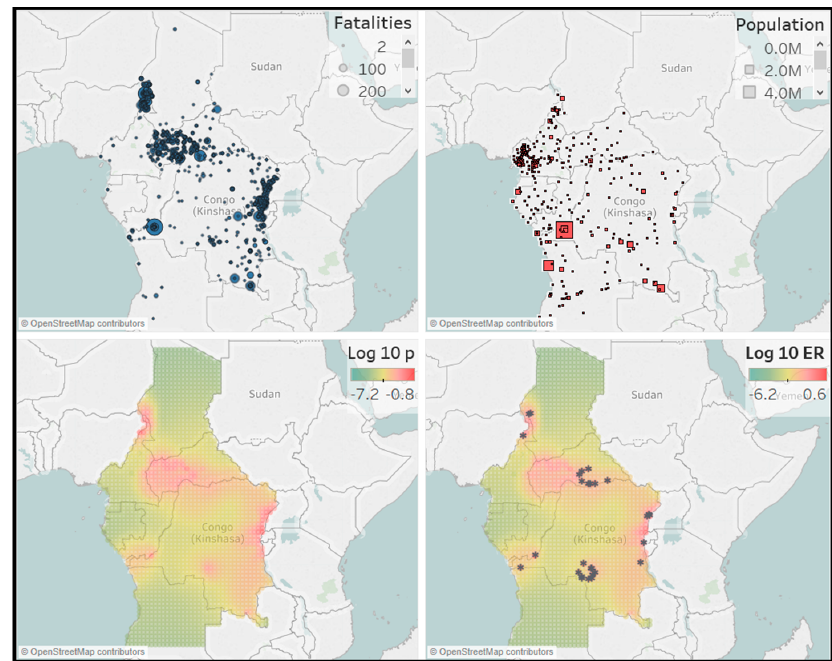
Figure 13. Forecasts for Central Africa. Top left: event catalog 2012–2016. Top right: City map with cities with 1000+ population. Bottom left: spatial background distribution estimated from the data from 2012–2016. Bottom right: forecast for the expected number of events with 𝑀 ≥ 4 in each cell in the year 2017, together with the locations of the actual conflicts that have taken place with 𝑀 ≥ 4 .